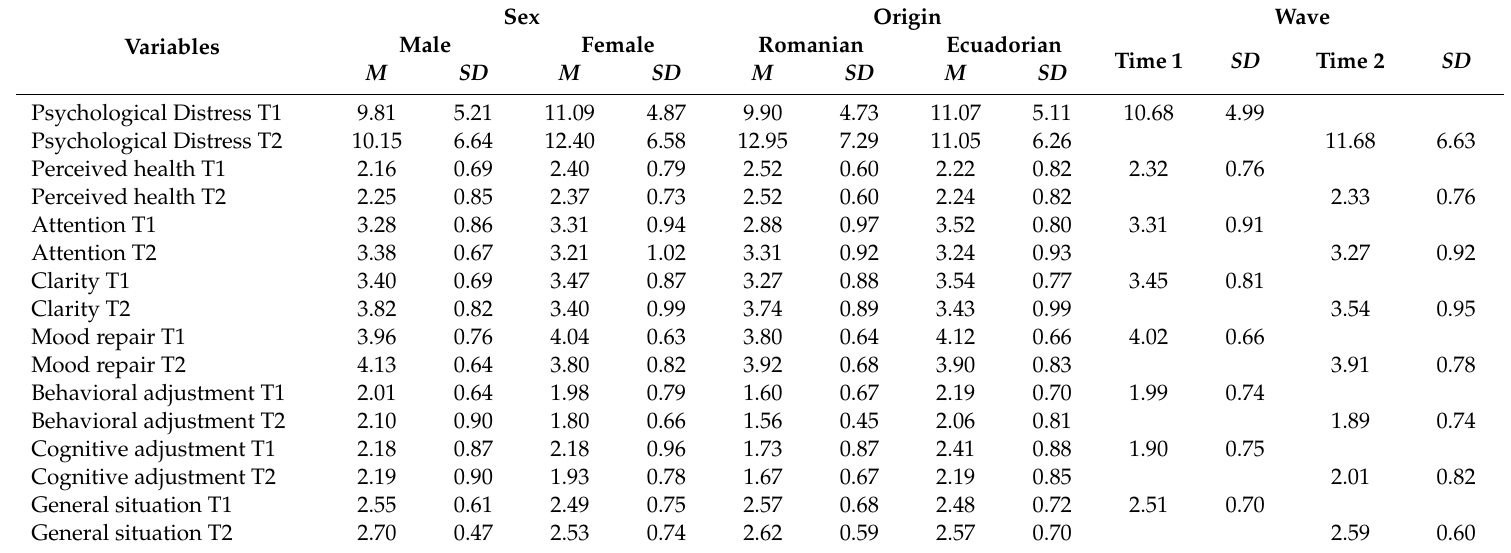
Table 2. Means and standard deviations of the variables of